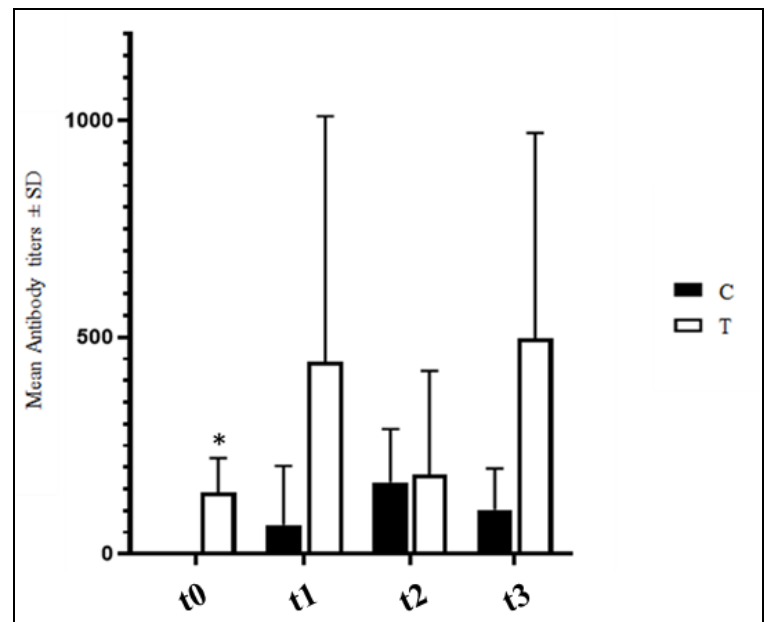
Figure 2. Mean IBV antibody titers ± SD detected in C and T groups. T = supplemented hens ( n = 60); C = control hens ( n = 60); t0 = start of the trial; t1 = after 5 weeks of supplementation; t2 = end of supplementation; t3 = end of the trial. *: statistically significant at p <